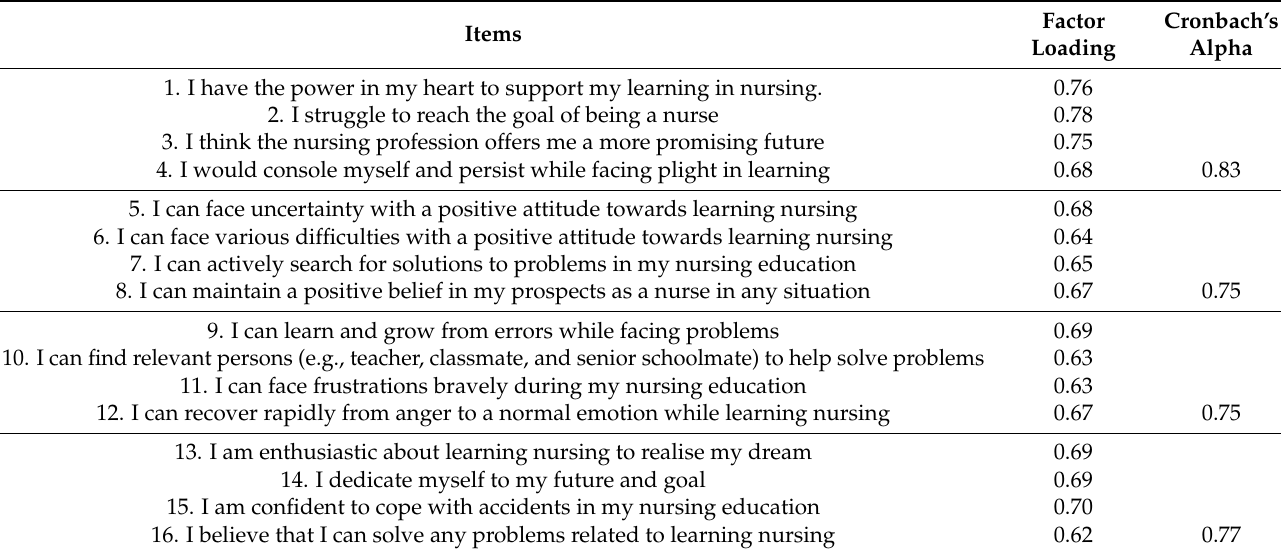
Table 1. Factor loadings and reliability coefficients of the PsyCap Scale (N = 384).